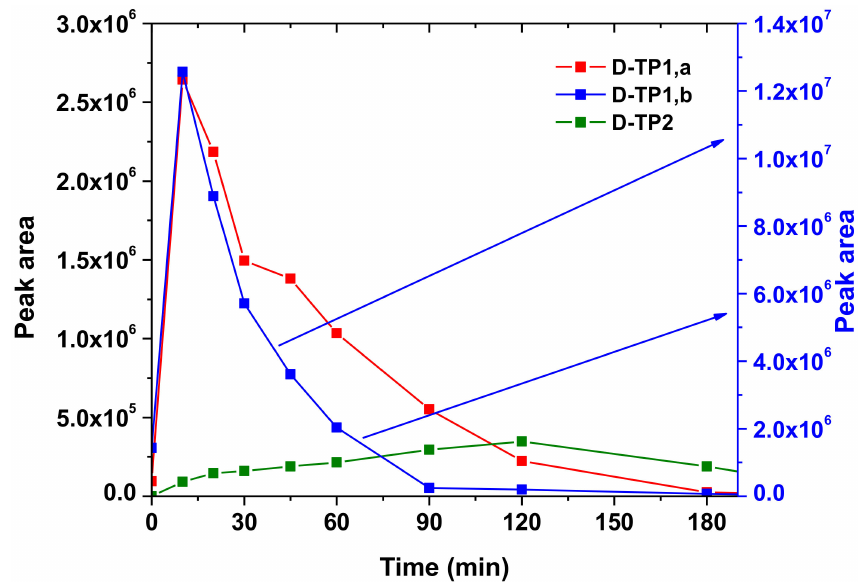
Figure 11. Evolution profiles of TPs generated from DCF by PEF/TiO 2 20 wt% under SSL,